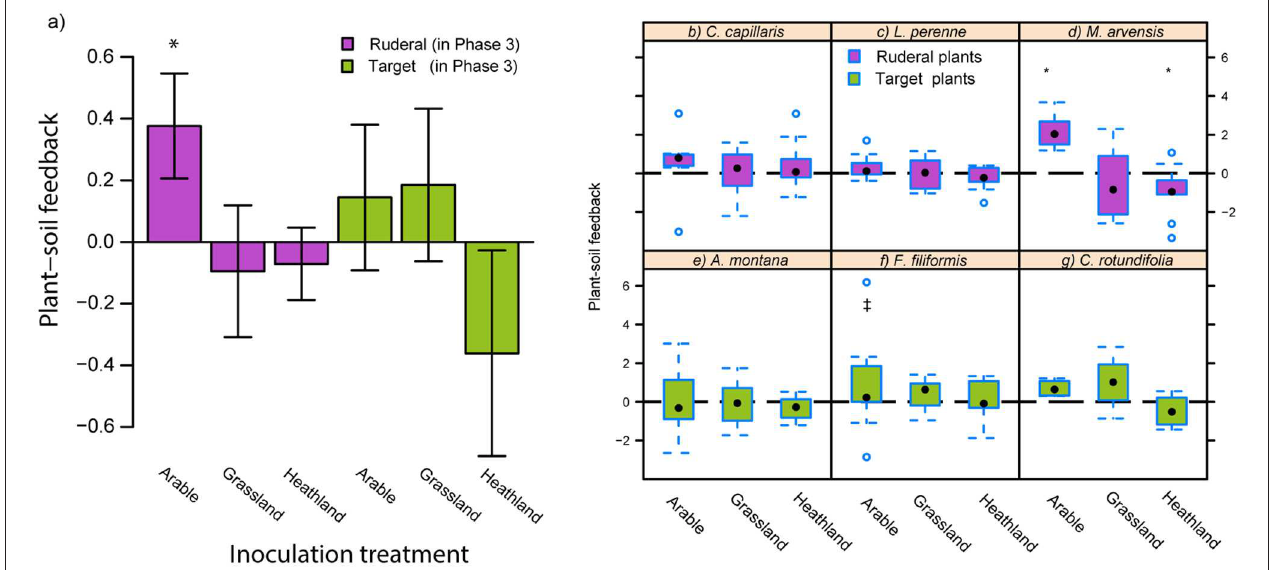
FIGURE 1 | Mean ( ± SE) plant species group PSFs in Phase 3 based on shoot biomass (a) , boxplots showing PSF per species (b–g) . The box extends from the lower to the upper quartile, while the thick dot represents the median. The whiskers represent the 5th and 95th percentile. Any data points beyond these cut-offs are individually presented. Plants grew in mixtures of ruderal and late-successional plant species, respectively, in pots in Phase 3. Significance of PSF effects are based on planned contrasts (* p < 0.05, ‡ p = 0.0669; Tables S2, S3